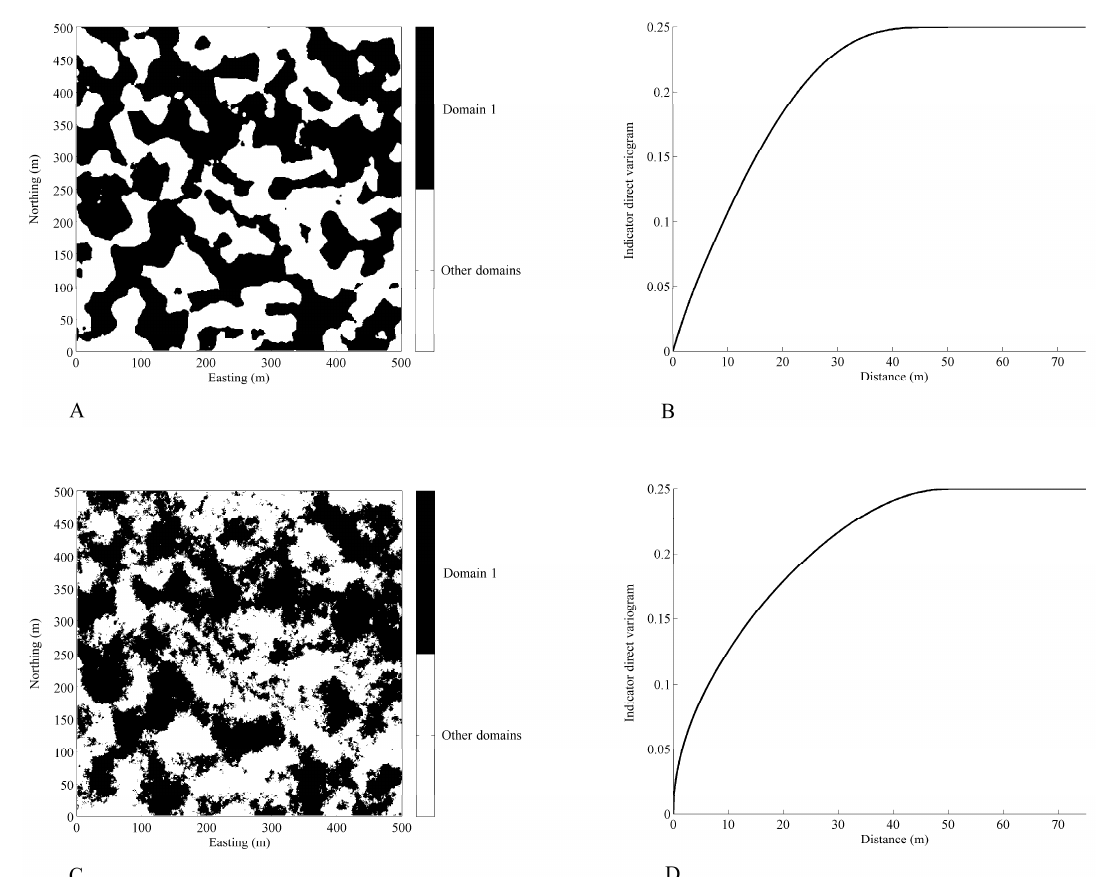
Figure 1. Plan views of geological domains ( A , C ) and indicator variograms of domain D 1 ( B , D ). The regularity of the domain boundary is reflected in the first-order derivative of the indicator direct variogram at the origin: regular domain boundary ( A ) associated with a finite variogram slope at the origin ( B ); fractal domain boundary ( C ) associated with an infinite variogram slope at the origin ( D ).